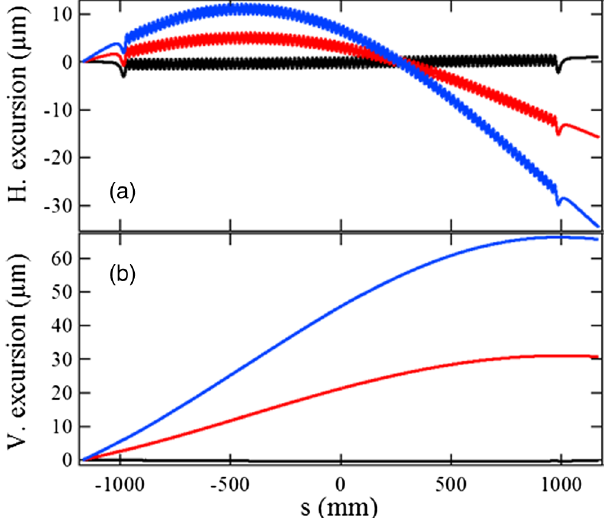
FIG. 6. Horizontal (a) and vertical (b) trajectory of one electron in the U20 undulator taking into account the 10 T solenoid field effect. Horizontal and vertical entrance angle are equal to 0 μ rad (black), 14 μ rad (red) and 30 μ rad (blue). For solenoid field values less or equal to 10 T, the number of oscillations of the trajectory is much smaller than one, the trajectory is only bent.